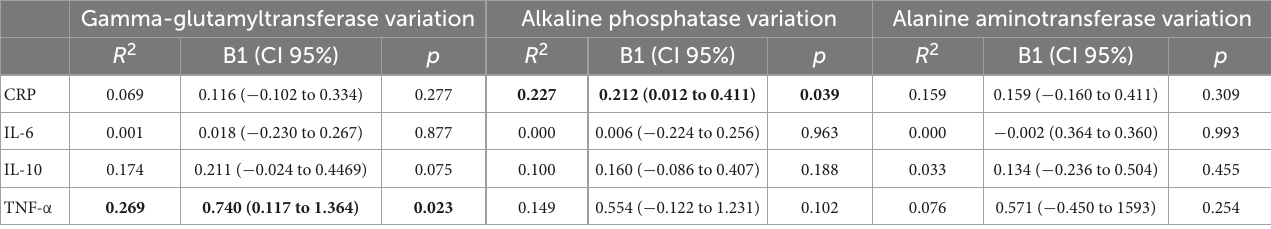
TABLE 2 Simple linear regression to analyze the association of liver function test variations and inflammatory parameters. Gamma-glutamyltransferase variation Alkaline phosphatase